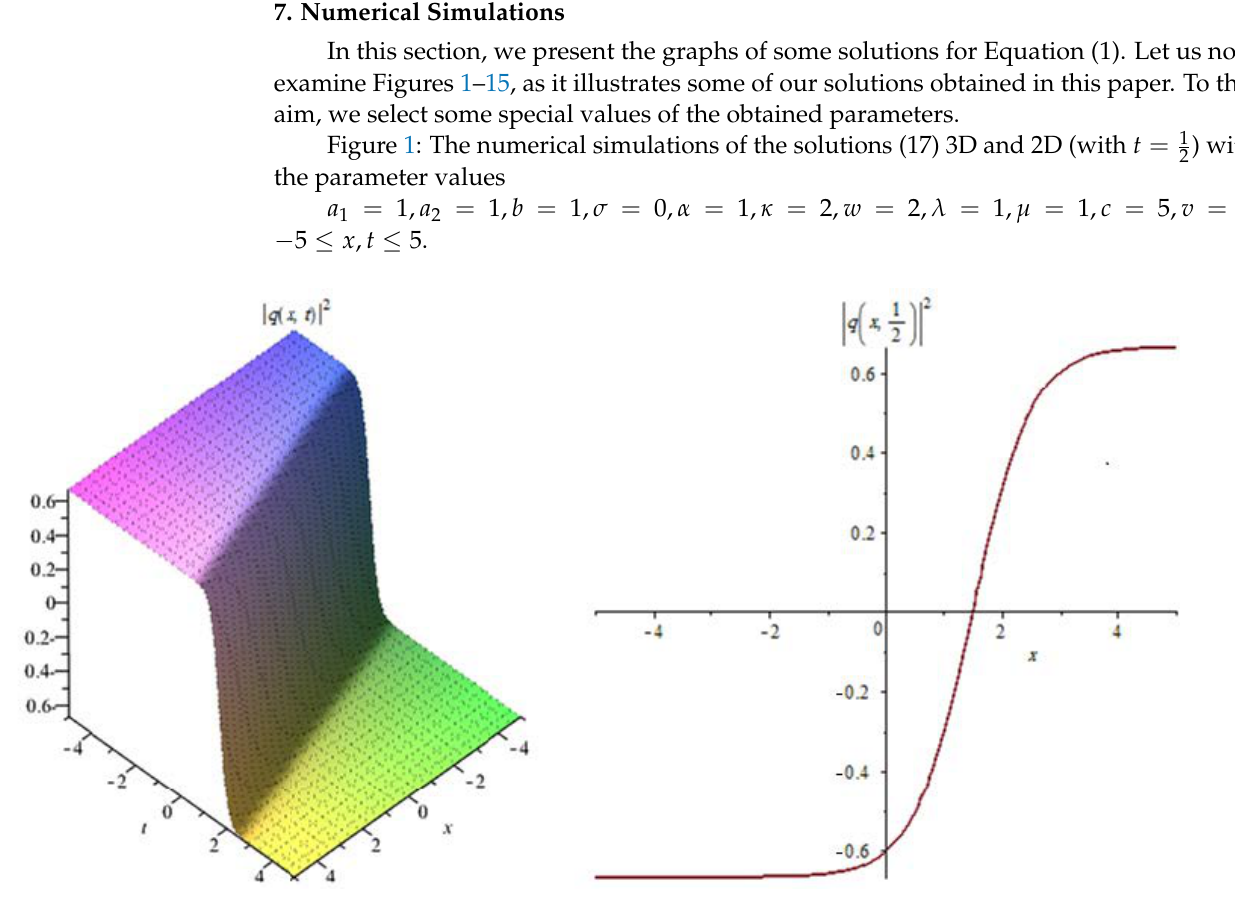
Figure 1. The profile of the dark soliton solutions (17). Figure 2: The numerical simulations of the solutions (17) 3D and 2D (with t = 1 the parameter values a 1 = 1, a 2 = 1, b = 1, σ = 1, α = 1, κ = 2, w = 2, λ = 1, µ = 1, 5 5. c = 5, v = 4, x , t − ≤ ≤